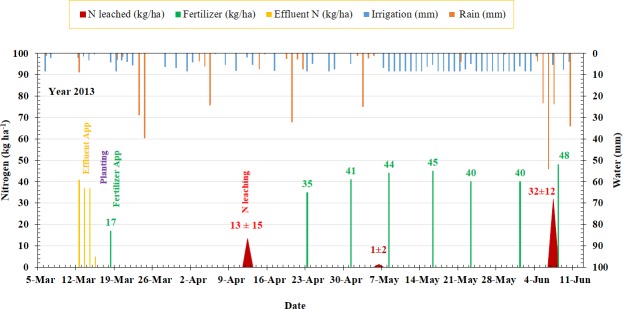
Chronosequence of leaching events in relation to water inputs (irrigation and rainfall) and nitrogen inputs (effluent N and fertilizer-N) for sweet corn grown during spring 2013.